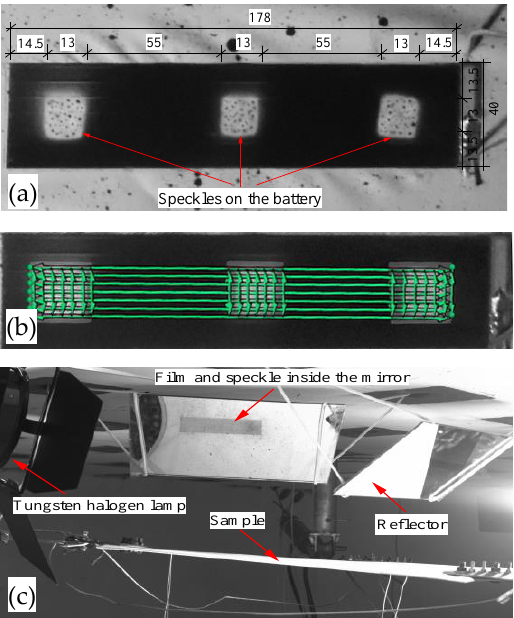
Figure 4. Speckle position and expansion deformation data: ( a ) thin film battery and the speckles on it (unit: mm), ( b ) data extraction of thin-film battery deformation, ( c ) film battery image and speckle inside the mirror.